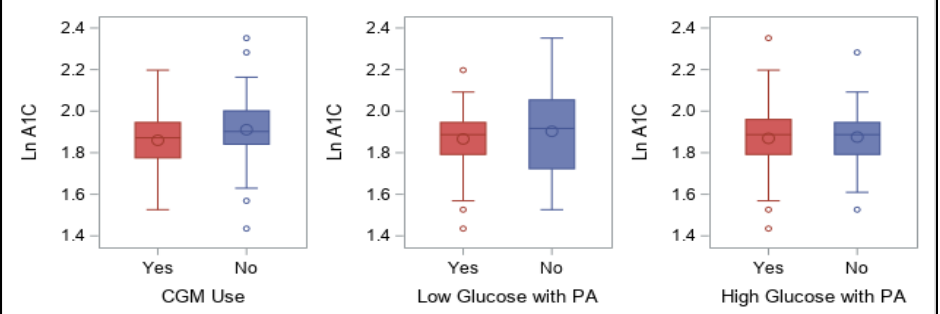
Figure 8. Use of CGM and physical activity-related low and high glucose and association with log A1C values.